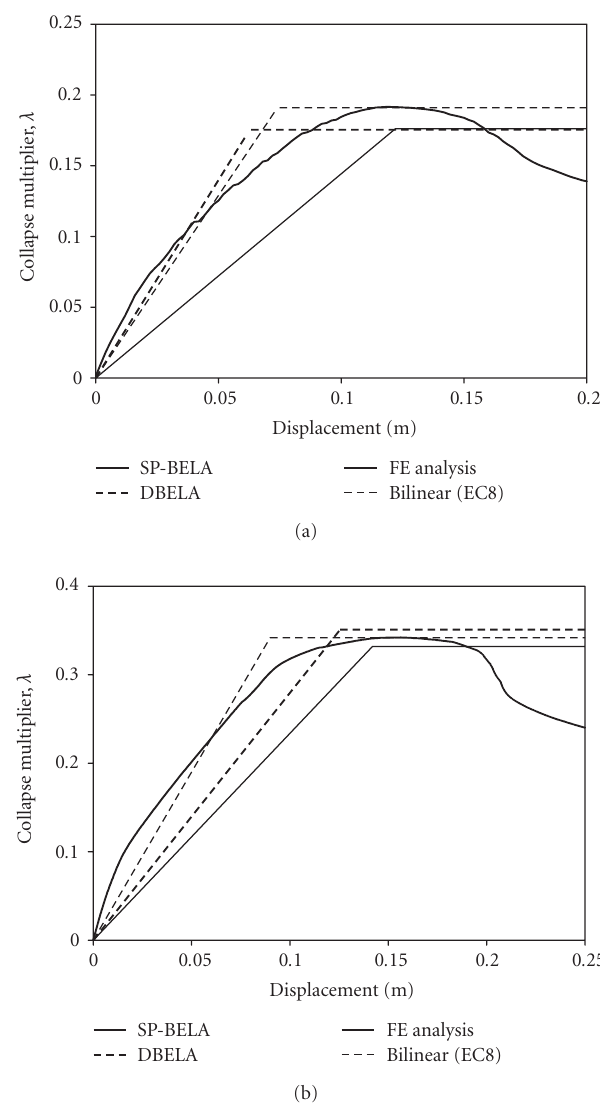
Figure 5: Comparison of pushover analyses in x direction of the building in Figure 3 (a) nonseismically designed (b) c =